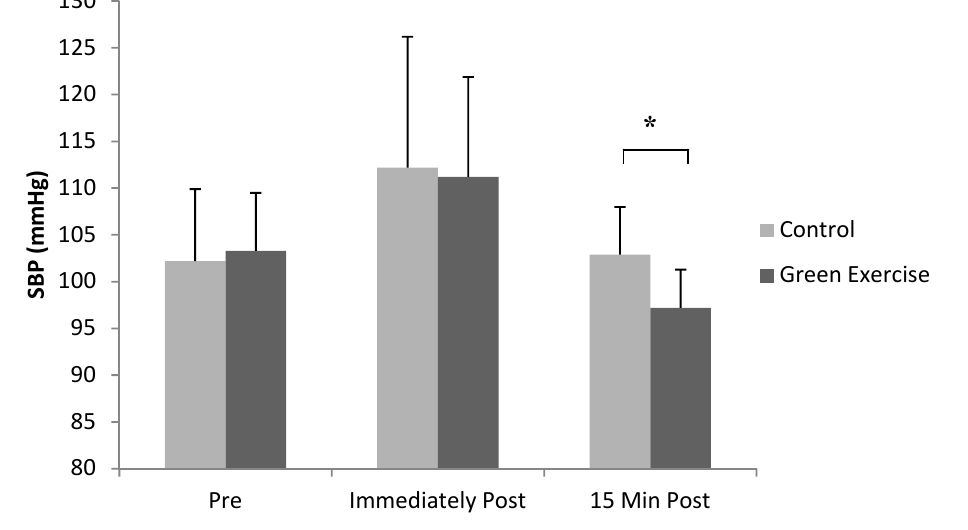
Figure 1. Mean ± SE of SBP scores, pre, immediately post and 15 min post green exercise or exercise alone (n = 14, * p = 0.01).